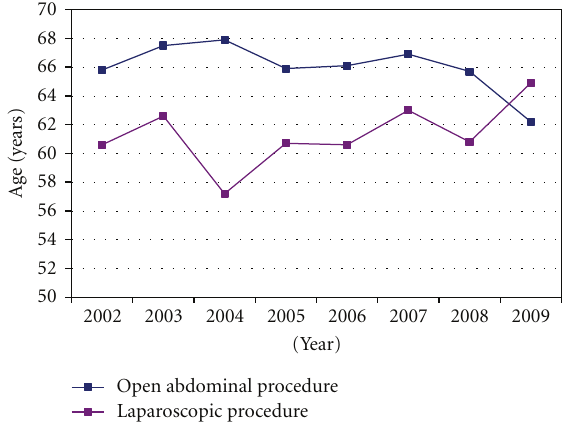
Figure 3: Mean age of women having laparoscopic and open abdominal procedures in 2002–2009.